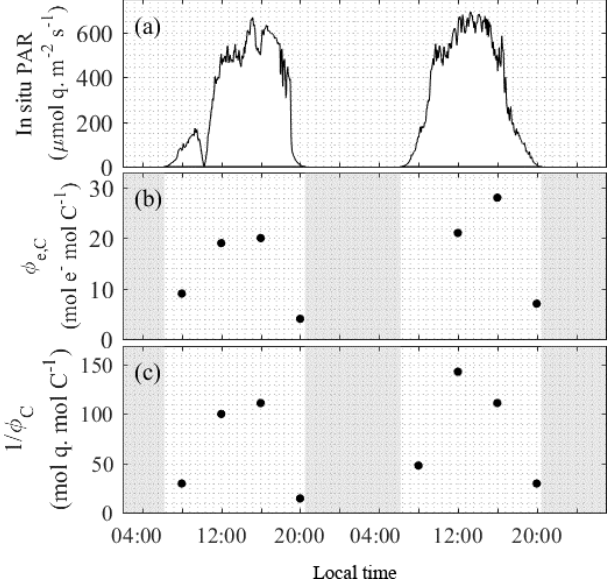
Figure 5. The realized electron and photon requirements of carbon fixation over a 48h diurnal cycle at the OCE17 site. Values of (cid:56) e , C and 1/ (cid:56) C correspond to light conditions at the time and depth of sampling. Note that we present the photon requirement for carbon fixation, 1 /(cid:56) C , instead of the photon efficiency of carbon fixation ( (cid:56) C ), to facilitate better comparability with (cid:56) e , C .